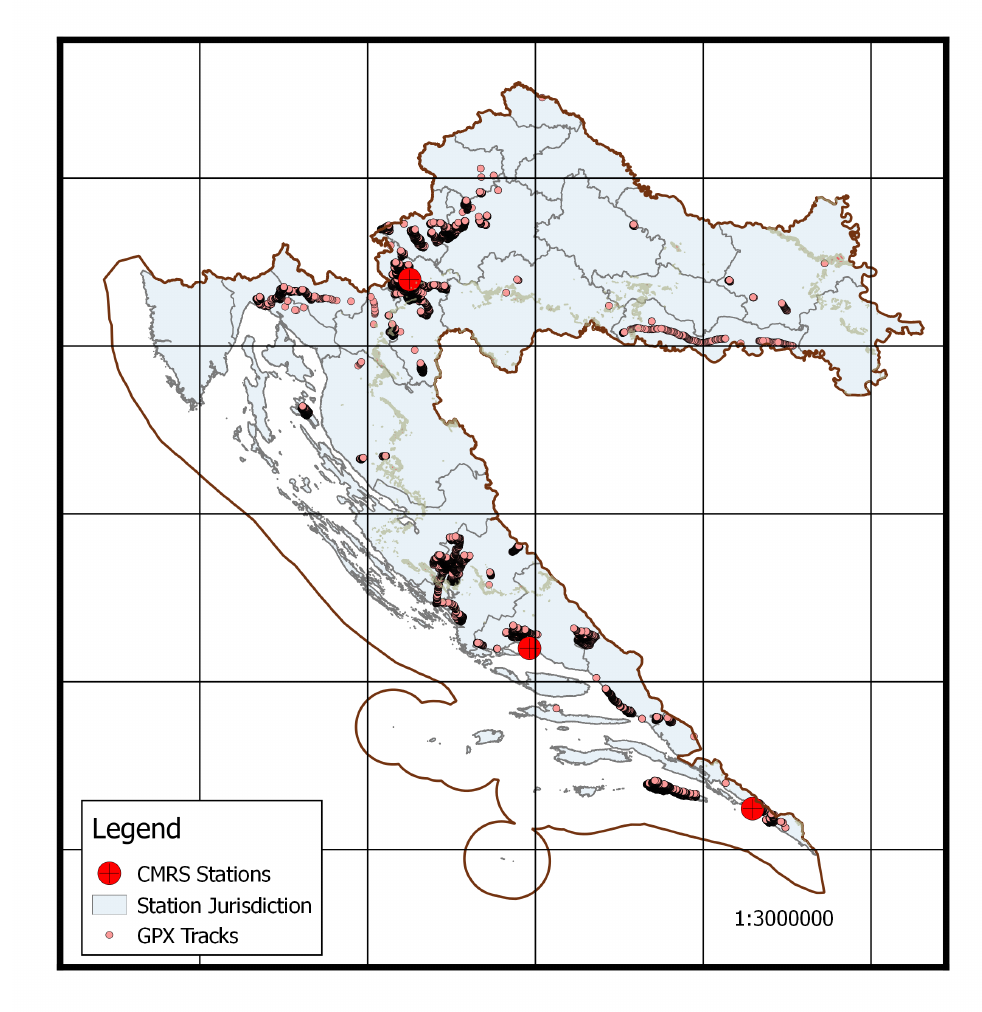
Figure 2. Spatial distribution of the GPX files data. The GPX trails are collected from three Mountain rescue service departments—Split, Karlovac and Dubrovnik. The trails are collected in a wide area of the three